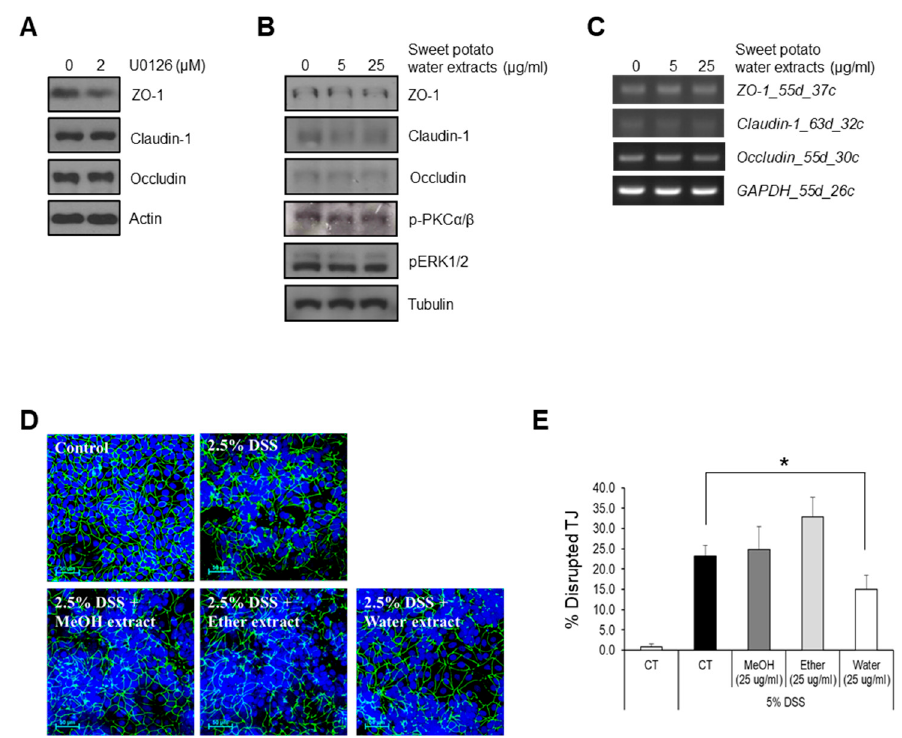
Figure 6. Effect of sweet potato extracts on tight junctions in Caco-2 cells. The effect of sweet potato water extract on tight junctions was assessed. ( A ) Caco-2 cells were treated with ERK inhibitor, U0126, and the expression of tight junction-related proteins was assessed by Western blotting. Caco-2 cells were treated with sweet potato water extract with the indicated concentrations, and the expression of tight junction-related proteins was assessed by Western blotting ( B ) and RT-PCR ( C ). ( D ) Caco-2 cells were treated with 2.5% DSS +/ − MeOH, ether, or water extracts. Immunofluorescence assay for ZO-1 was performed to assess the orientation of tight junctions. Scale bar = 50 µm. ( E ) Quantification of immunofluorescence assay. Percent disrupted tight junctions was calculated by dividing the number of ZO-1-disrupted (wrinkled or discontinued) cells by the total number of cells in high-power fields. Data are presented as mean ± SEM of three independent experiments. All Western blot results were quantified by using Image J. * p < 0.05.